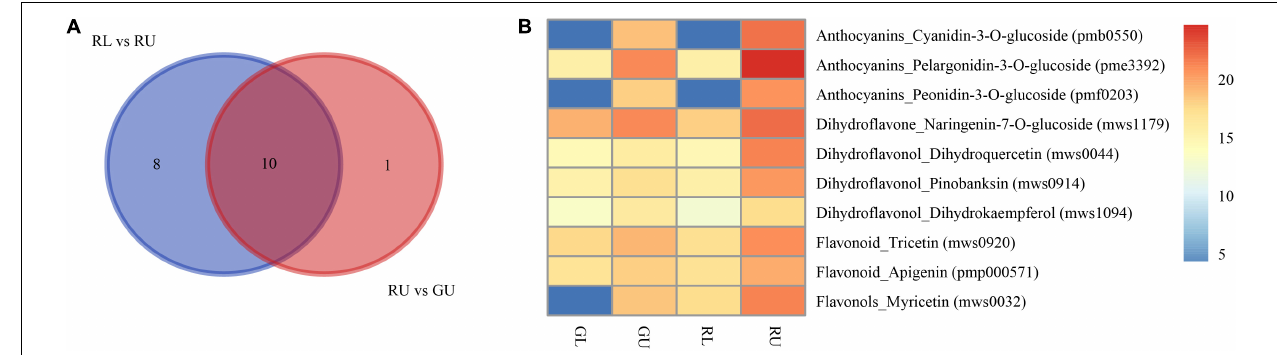
FIGURE 5 | Metabolites related to red young leaves in H. hainanensis . (A) Venn diagram indicating the DAMs enriched into phenylpropanoid biosynthesis (ko00940), flavonoid biosynthesis (ko00941), and anthocyanin biosynthesis (ko00942) in the comparison of RU vs. GU and RL vs. RU. (B) Relative abundance of red color related metabolites in RU vs. GU and RL vs. RU indicates log2Relative abundance.